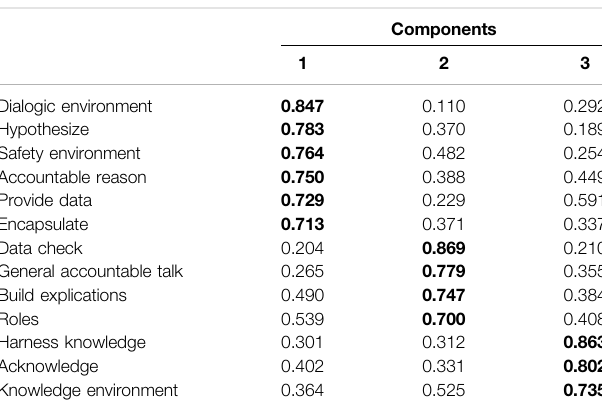
TABLE 8 | Rotated component matrix a